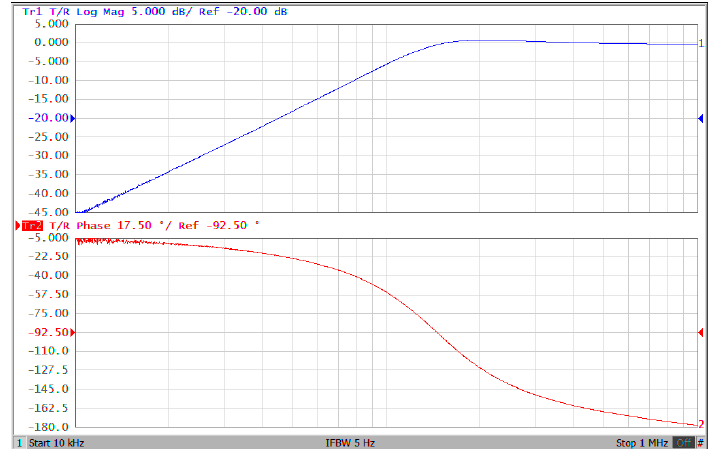
Figure 37. Experimentally observed gain and phase responses of the IHP filter realized in case II.